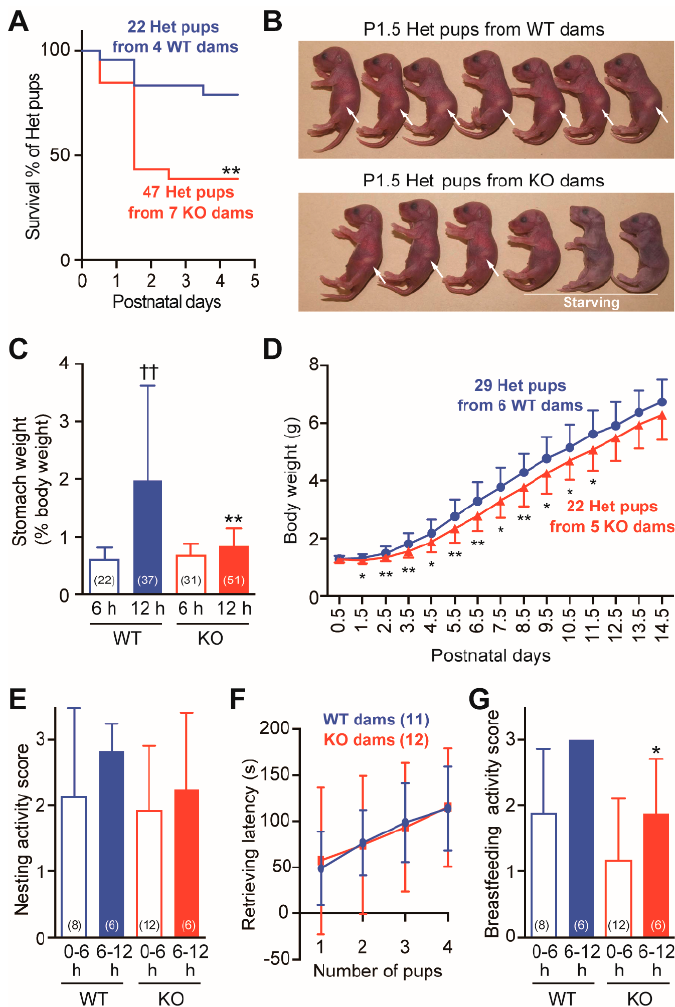
Figure 3. Frequent neonatal lethality in pups born to Cth − / − dams due to defective lactation. ( A ) Kaplan–Meier survival analyses up to postnatal day 5 in Cth +/ − pups born to wild-type (WT) and Cth − / − (KO) dams. The difference was significant at ** p < 0.01. ( B ) Typical appearance of all surviving Cth +/ − litters from a WT dam and partially dying Cth +/ − litters from a KO dam. Arrows indicate the presence